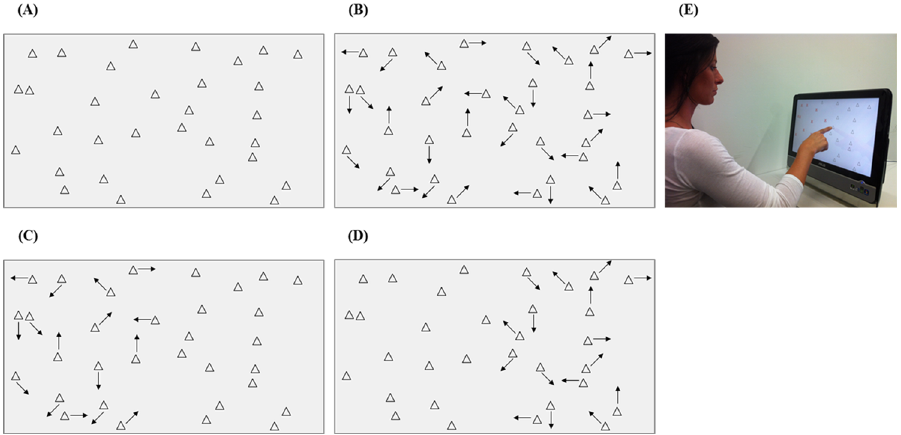
Fig 1. Static and dynamic conditions, and touchscreen apparatus. The four conditions performed by every participant. In the pictures, the arrows represent motion. A) Static: all targets are stationary. B) Dynamic: all targets move. C) Dynamic left: targets within the left hemiscreen move, and targets within the right hemiscreen are stationary. D) Dynamic right: targets within the right hemiscreen move, and targets within the left hemiscreen are stationary. E) Touchscreen apparatus, with a healthy participant performing the cancellation task with 32 triangular, non-coloured targets.